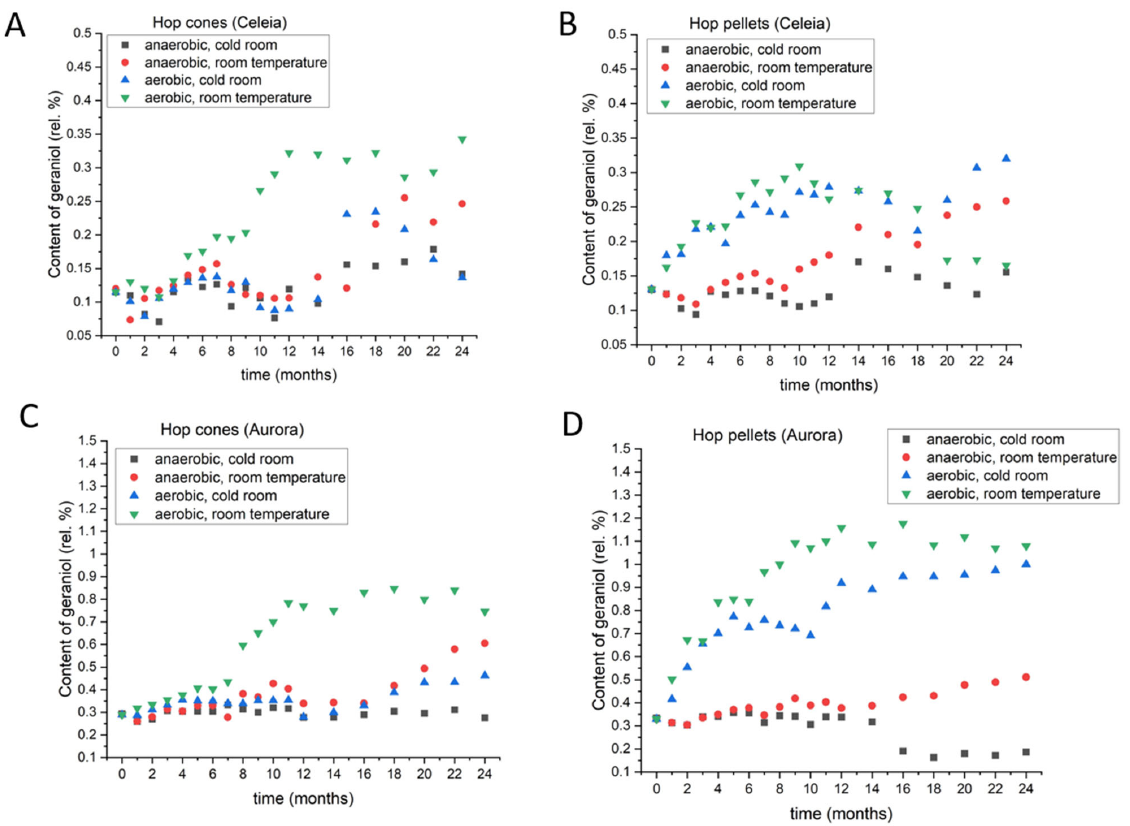
Figure 6. Changes in the content of geraniol in Celeia cones ( A ) and pellets ( B ) and Aurora cones ( C ) and pellets ( D ) during two-year period, under different storage conditions.